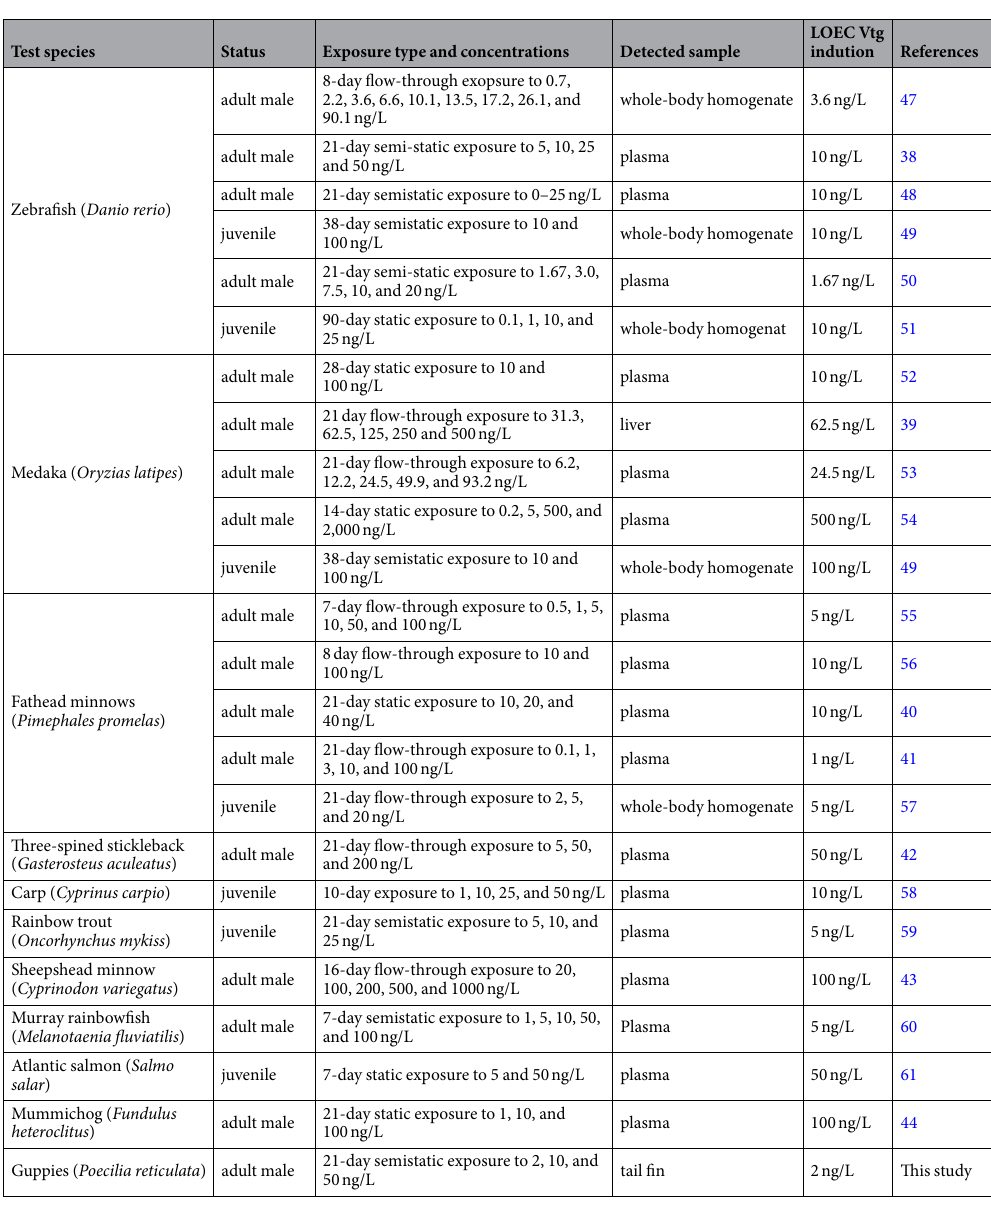
Table 2. Lowest observed effect concentration (LOEC) of Vtg induction in different fish exposed to waterborne 17 a